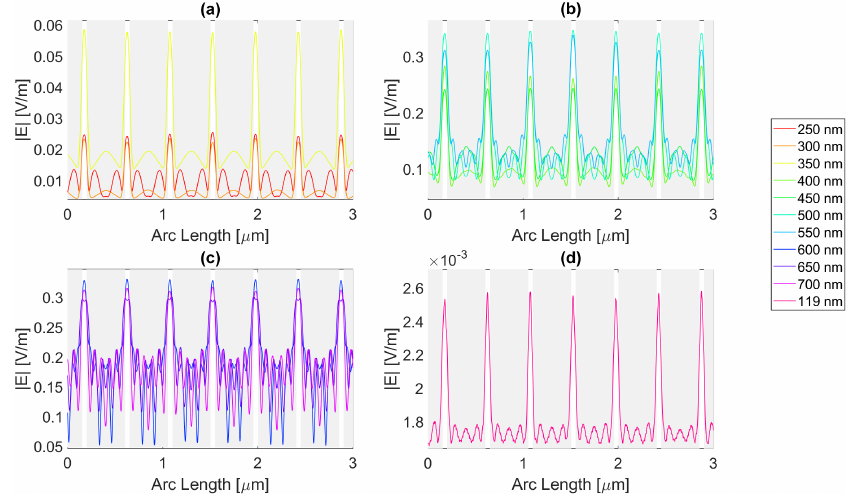
Figure 5. Electric field for aluminium 20-nm-thick rectangular nanostructure—Probe 1. On the other hand, the gold antenna reaches a maximum electric field of 4.00 × 10 − 1 V/m and field integral of 9.87 × 10 − 7 at a 600 nm wavelength, being the design of 20 nm thick- ness that has a maximum at the largest wavelength, as represented in Figure 6c. In Figure 6b, for wavelengths near the resonance wavelength 536 nm, from 450 to 700 nm, the field on